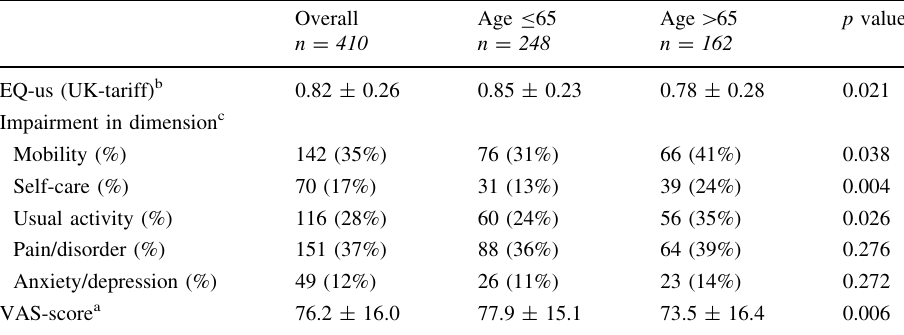
Table 3 EuroQol